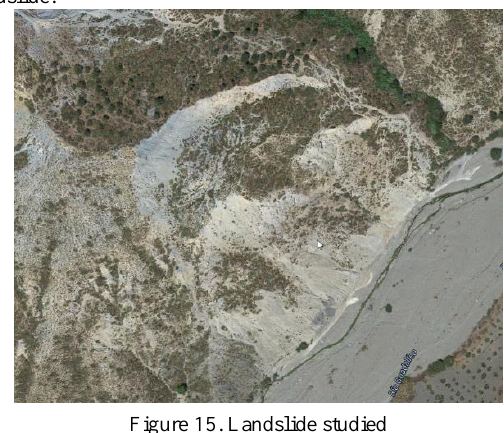
Figure 15. Landslide studied